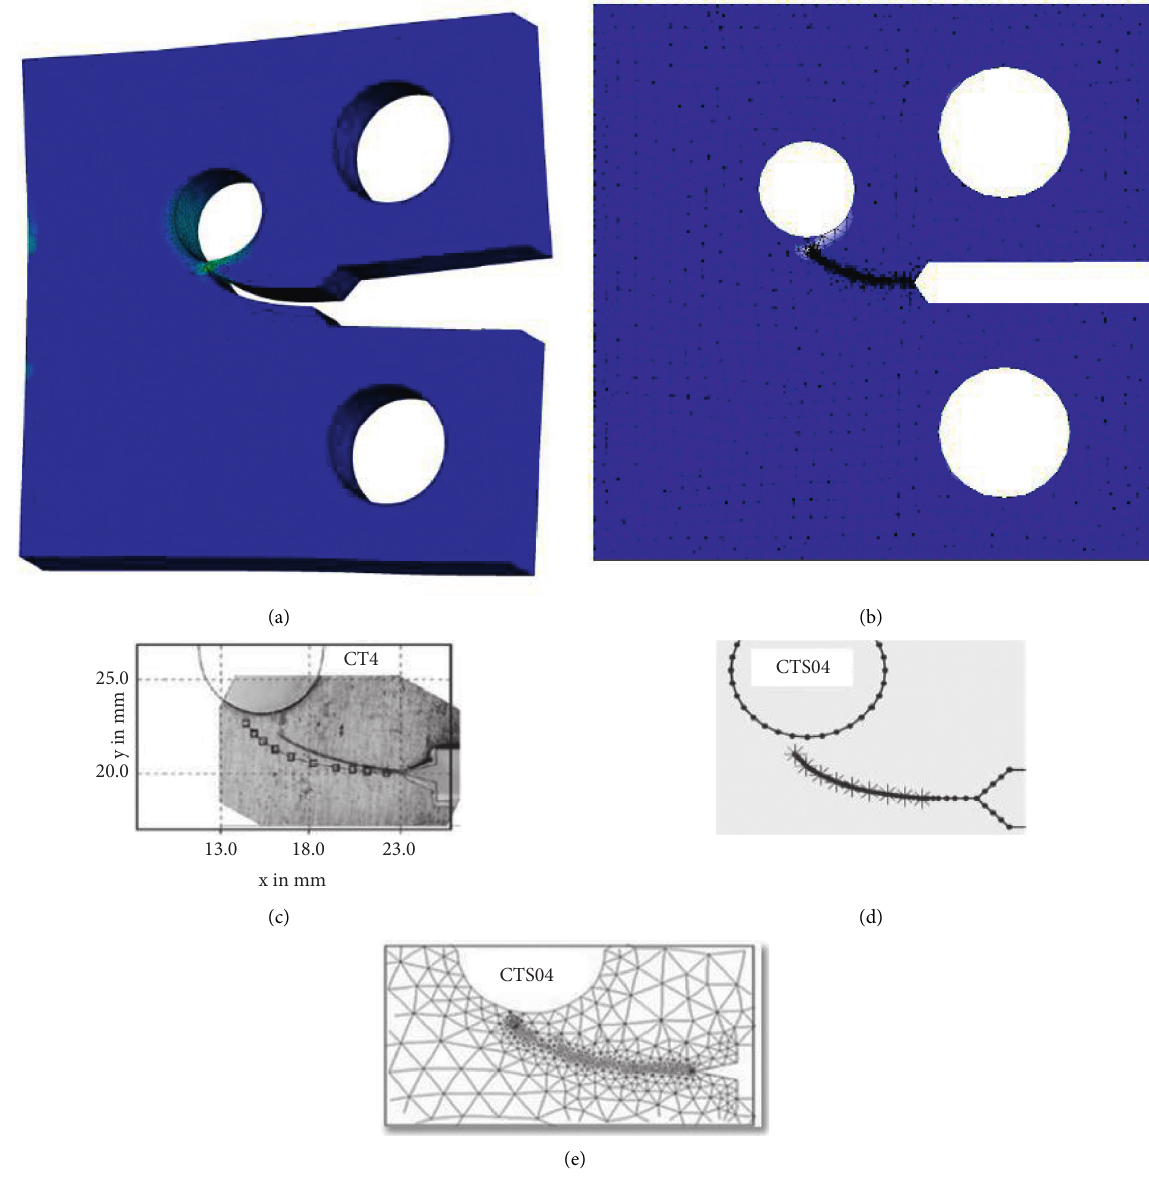
Figure 8: The predicted crack path of CTS04. (a) ANSYS results, (b) FRANC2D/L, (c) experimental and numerical outcome of [50], (d) BemCracker2D software [32], and (e) Quebra2D software